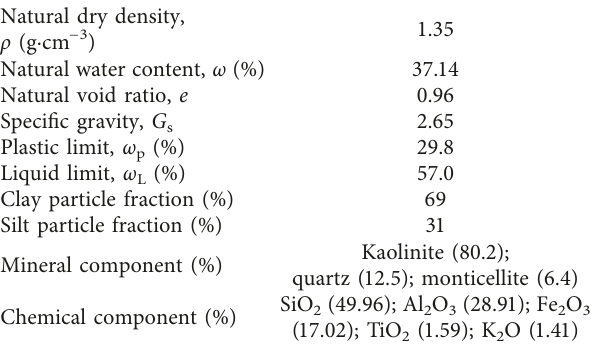
Table 1: Some geotechnical and chemical properties of laterite.